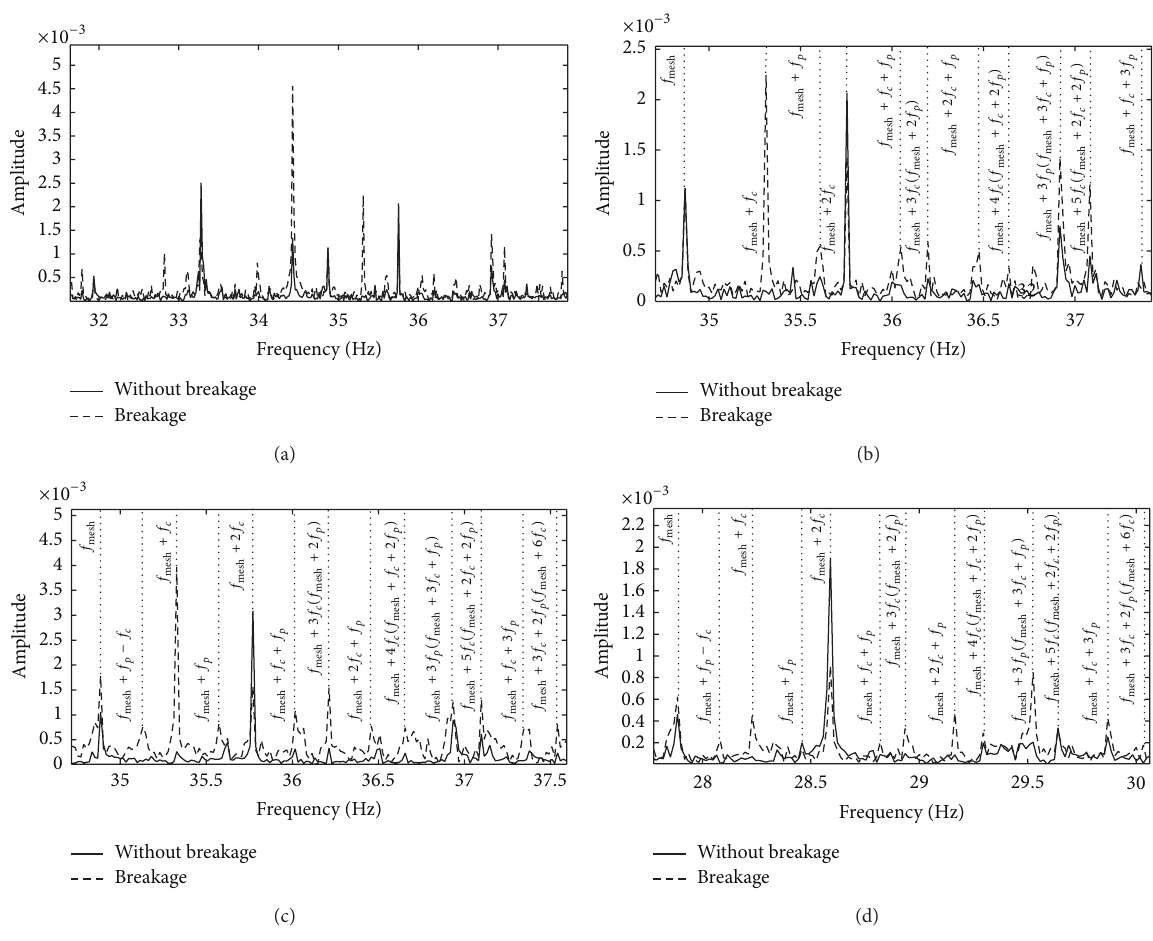
Figure 10: The spectrum of the system with and without tooth breakage on planet at different speeds and loads: (a) load = 200 N ⋅ m, input speed = 2.74 rad/s, (b) zoom the right side of (a), (c) load = 229 N ⋅ m, input speed = 2.74 rad/s, and (d) load = 229 N ⋅ m, input speed = 2.22